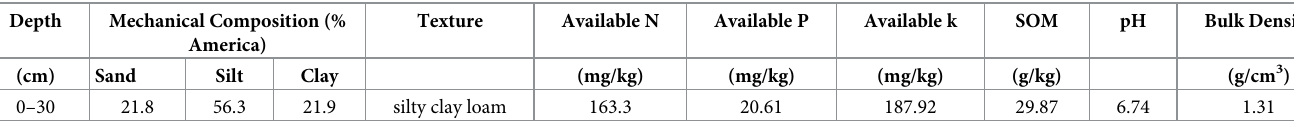
Table 1. Chemical and physical properties of soil top layers in experimental plots (American system).